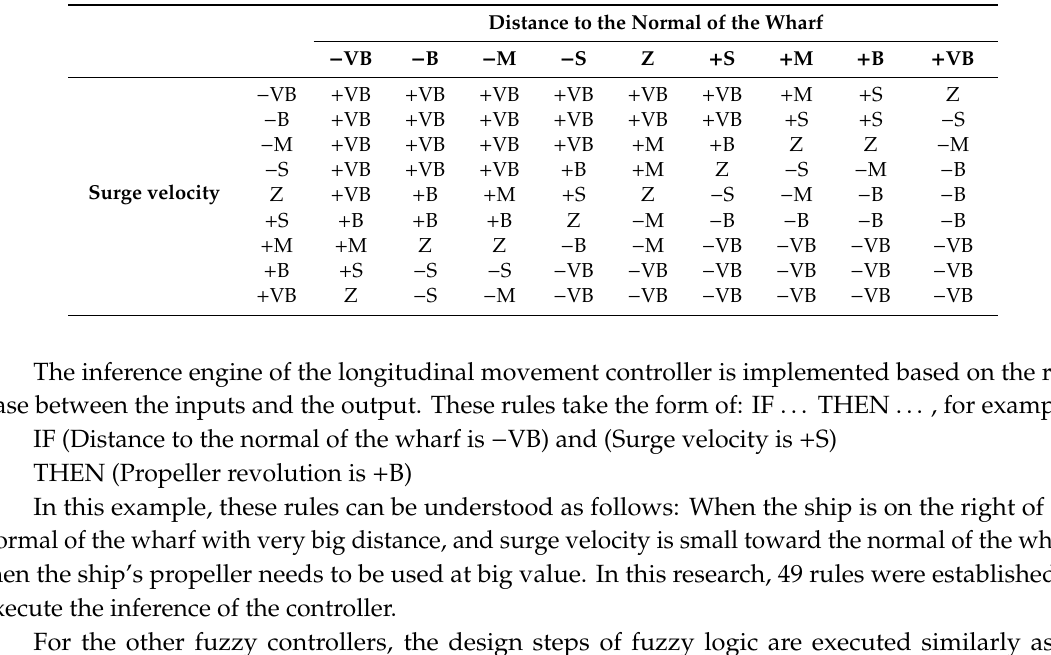
Table 5. The rule base for the first